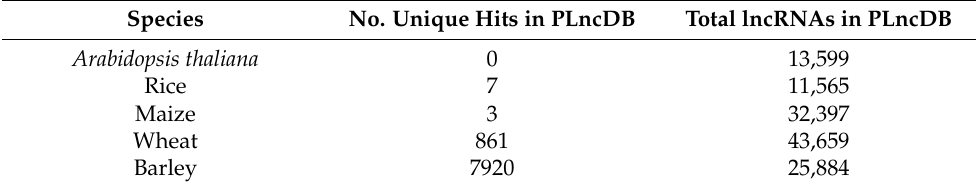
Table 1. Identification of homologous lncRNAs in barley and selected plant